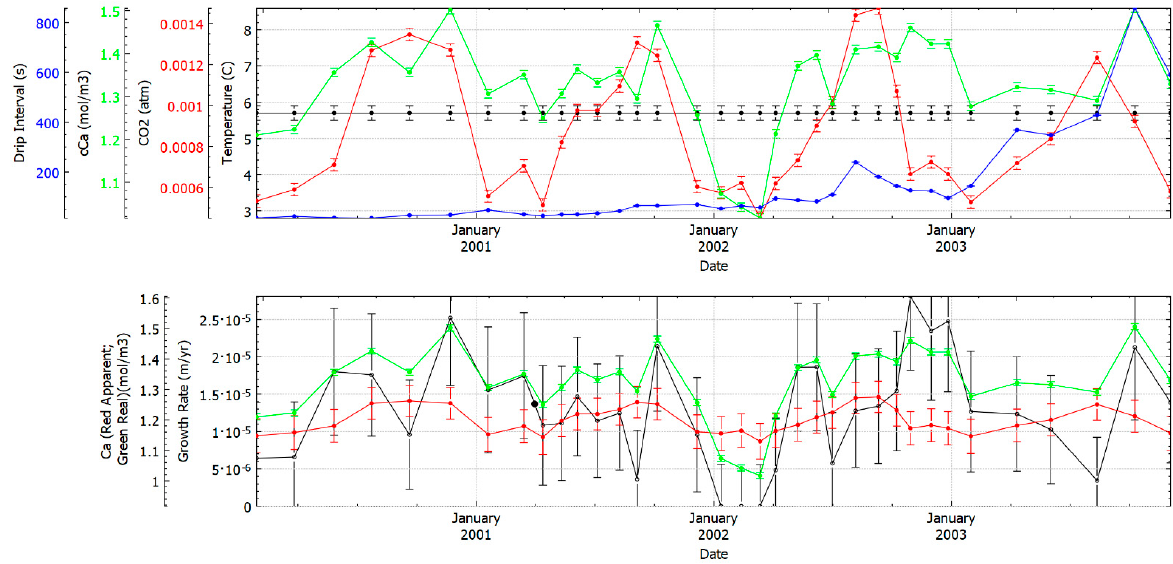
Figure 1. Growth rate calculation in Obir cave. The top plot shows the input parameters (temperature in black, cave pCO 2 concentration in red, drip water Ca concentration (cCa) in green and drip interval in blue). The bottom plot shows the output of StalGrowth: the calculated growth rate (black) and the apparent Ca-concentration (red), compared to the real calcium concentration (green).